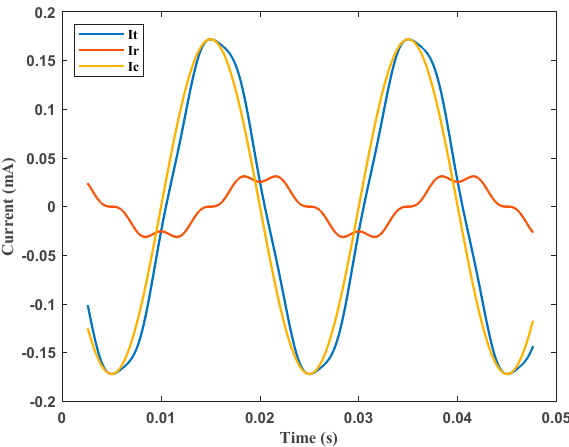
Figure 6. An example of capacitive, resistive, and total leakage currents.